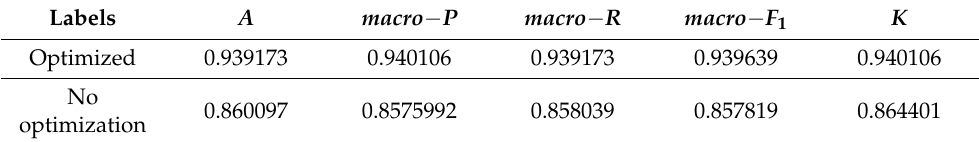
Table 6. Statistical table of numerical indicators of optimization and no optimization.